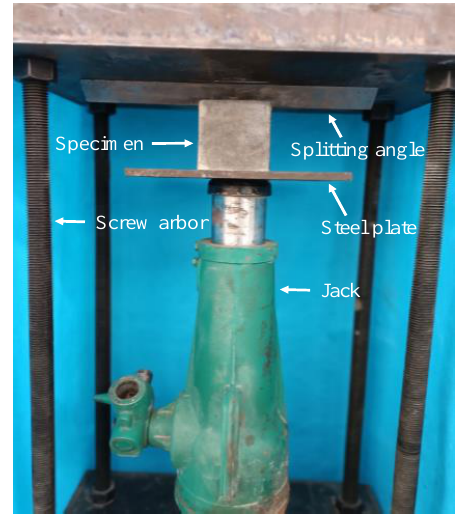
Figure 6. On-site splitting of corroded specimen.